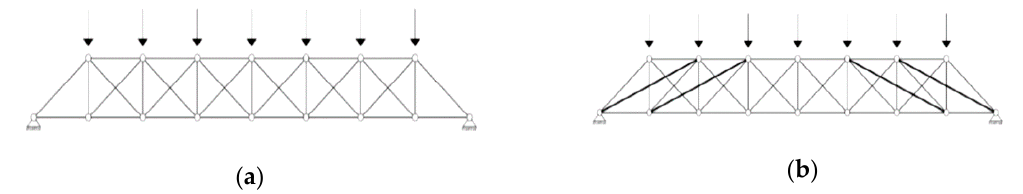
Figure 1. Increase of redundancy on the example of a truss system ( a ), by the addition of members and increase of its static indeterminacy ( b ).